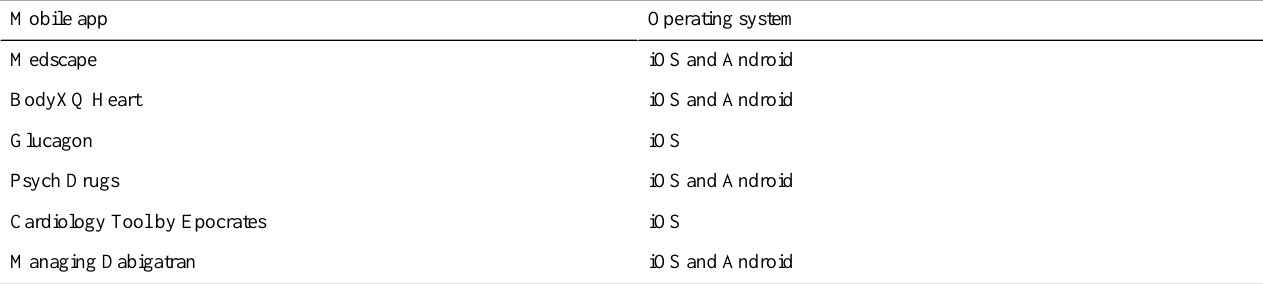
Table 1. Mobile apps used in class